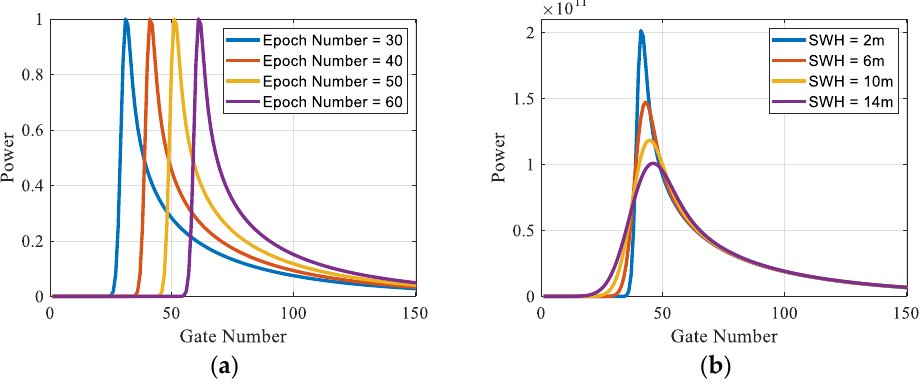
Figure 7. The SAR echo model with different ( a ) echo epoch (SWH = 2 m) and ( b ) SWH (Epoch = 40).